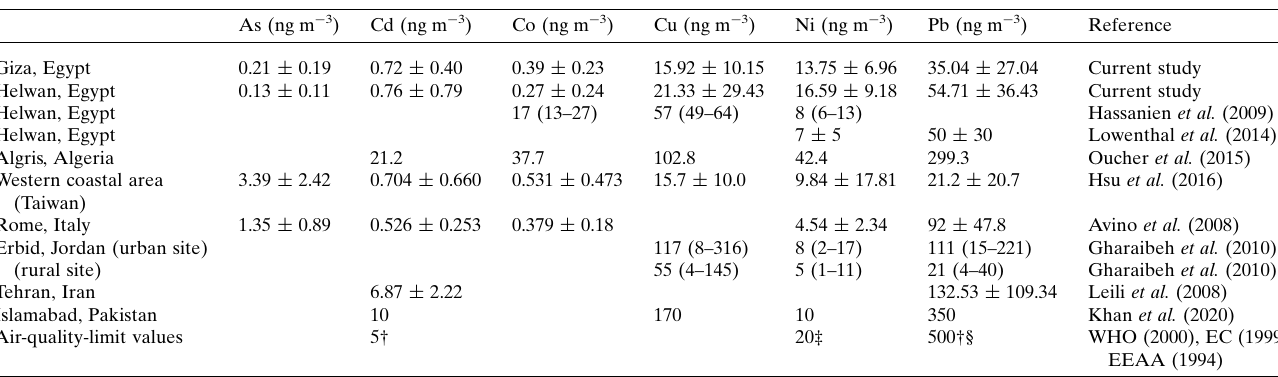
Table 3 Concentrations of heavy metals (ng m (cid:3) 3 ) associated with PM 10 in the studied samples and other areas worldwide. The literature data were not presented in a uniform way, sometimes with errors sometimes with